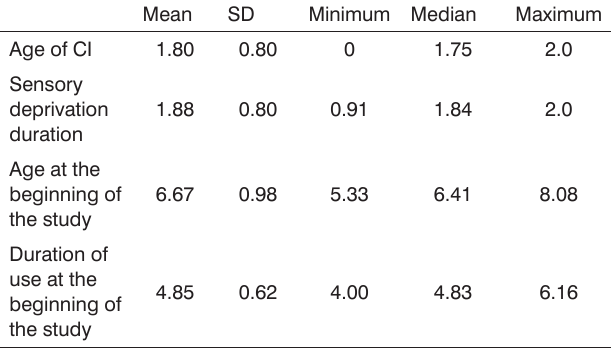
Table 1. Mean, standard deviation, median, minimum and maximum values (years) relative to the demographics of the 11 participants.